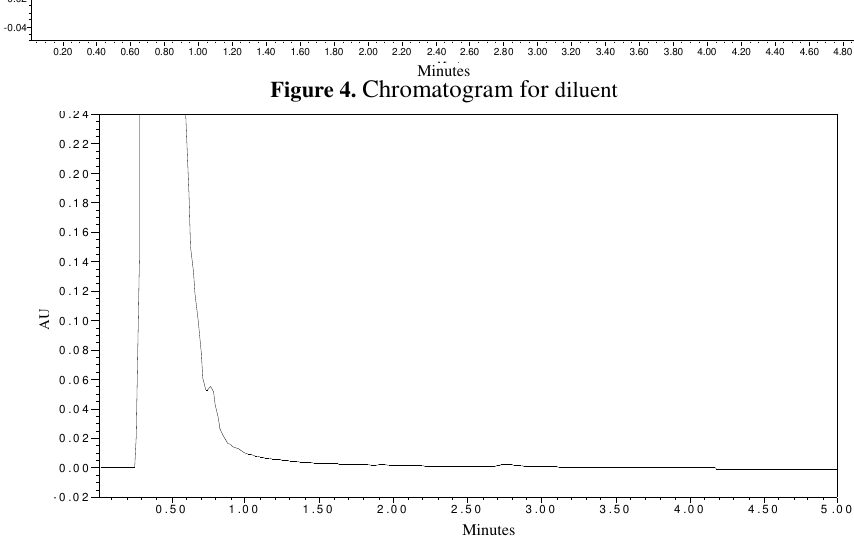
Figure 4. Chromatogram for